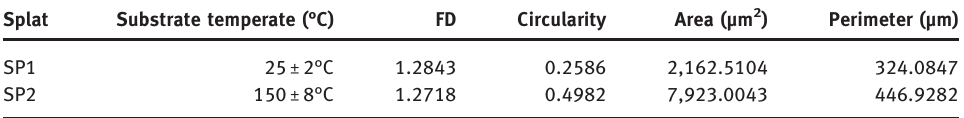
Table 2: The main parameters of two splats.